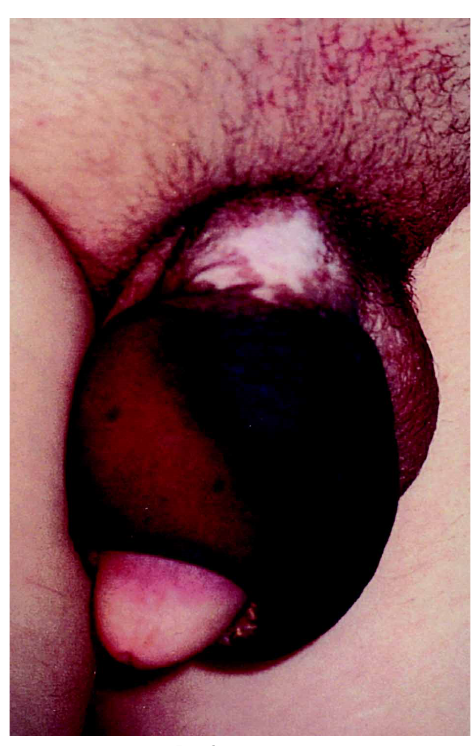
Figure 1 - Penile lymphedema caused by chronic strangulation. Figure 2 - Cosmetic result after